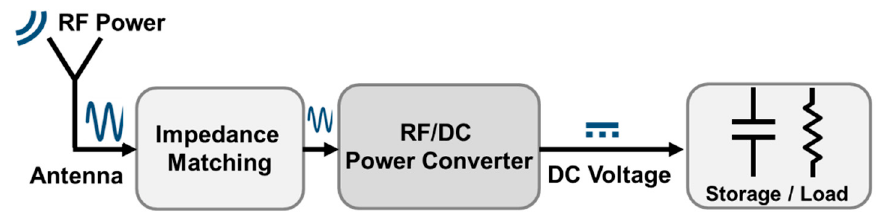
Figure 1. Typical block diagram of the WPT receiver.